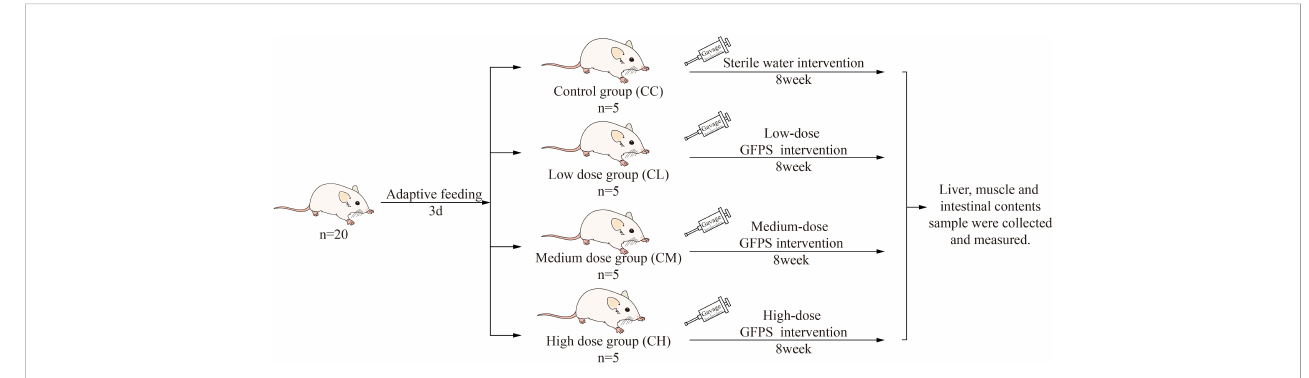
FIGURE 1 Experimental design and general conditions of the